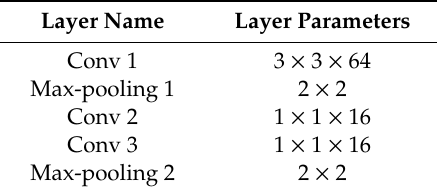
Figure 5. Six fault types of gray scale image. ( a ) normal condition, ( b ) inner race fault, ( c ) outer race fault, ( d ) cage fault, ( e ) inner and outer race fault, ( f ) inner race, ball, cage and outer race fault. Table 2. Layer parameter configurations.